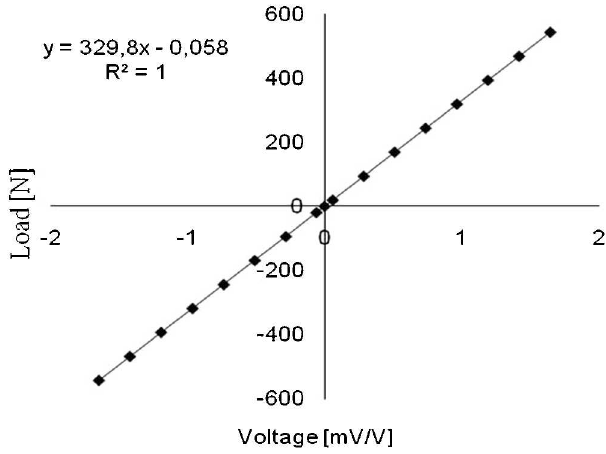
Figure 3 - Device calibration data in horizontal direction.